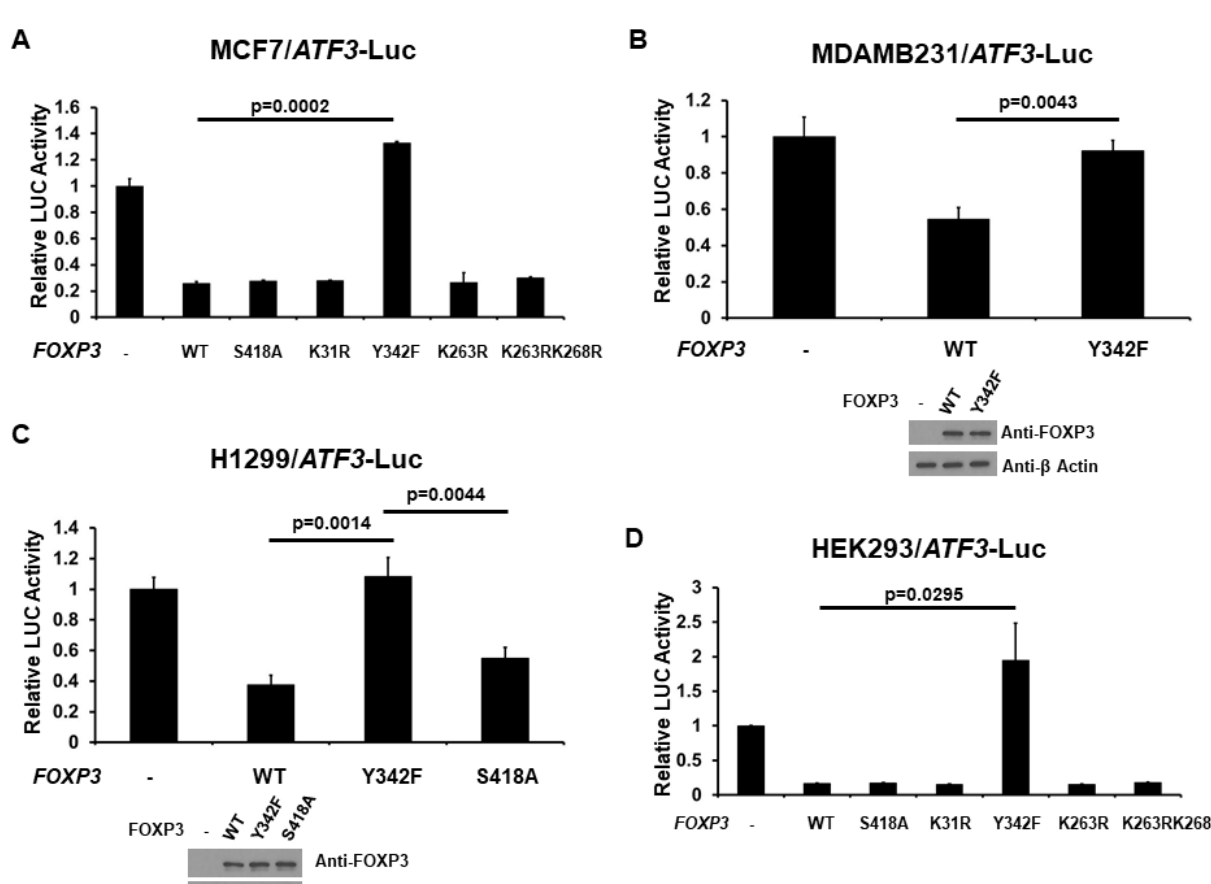
Figure 4. Post-translational modifications of FOXP3 regulate the repression of the ATF3 promoter. ( A ) MCF7, ( B ) MDAMB231, ( C ) H1299, and ( D ) HEK293 cells were co-transfected with the ATF3 promoter-LUC reporter plasmid and either wild-type (WT), S418A, K31R, Y342F, K263R, or K263RK268R FOXP3 expression plasmid. Luciferase activities were measured 48 h after transfection and normalized with Renilla activity. Relative LUC activity was calculated and plotted. The protein levels of FOXP3 and β Actin in the cells from the reporter assays were confirmed using anti-FOXP3 and anti- β Actin immunoblotting, respectively.